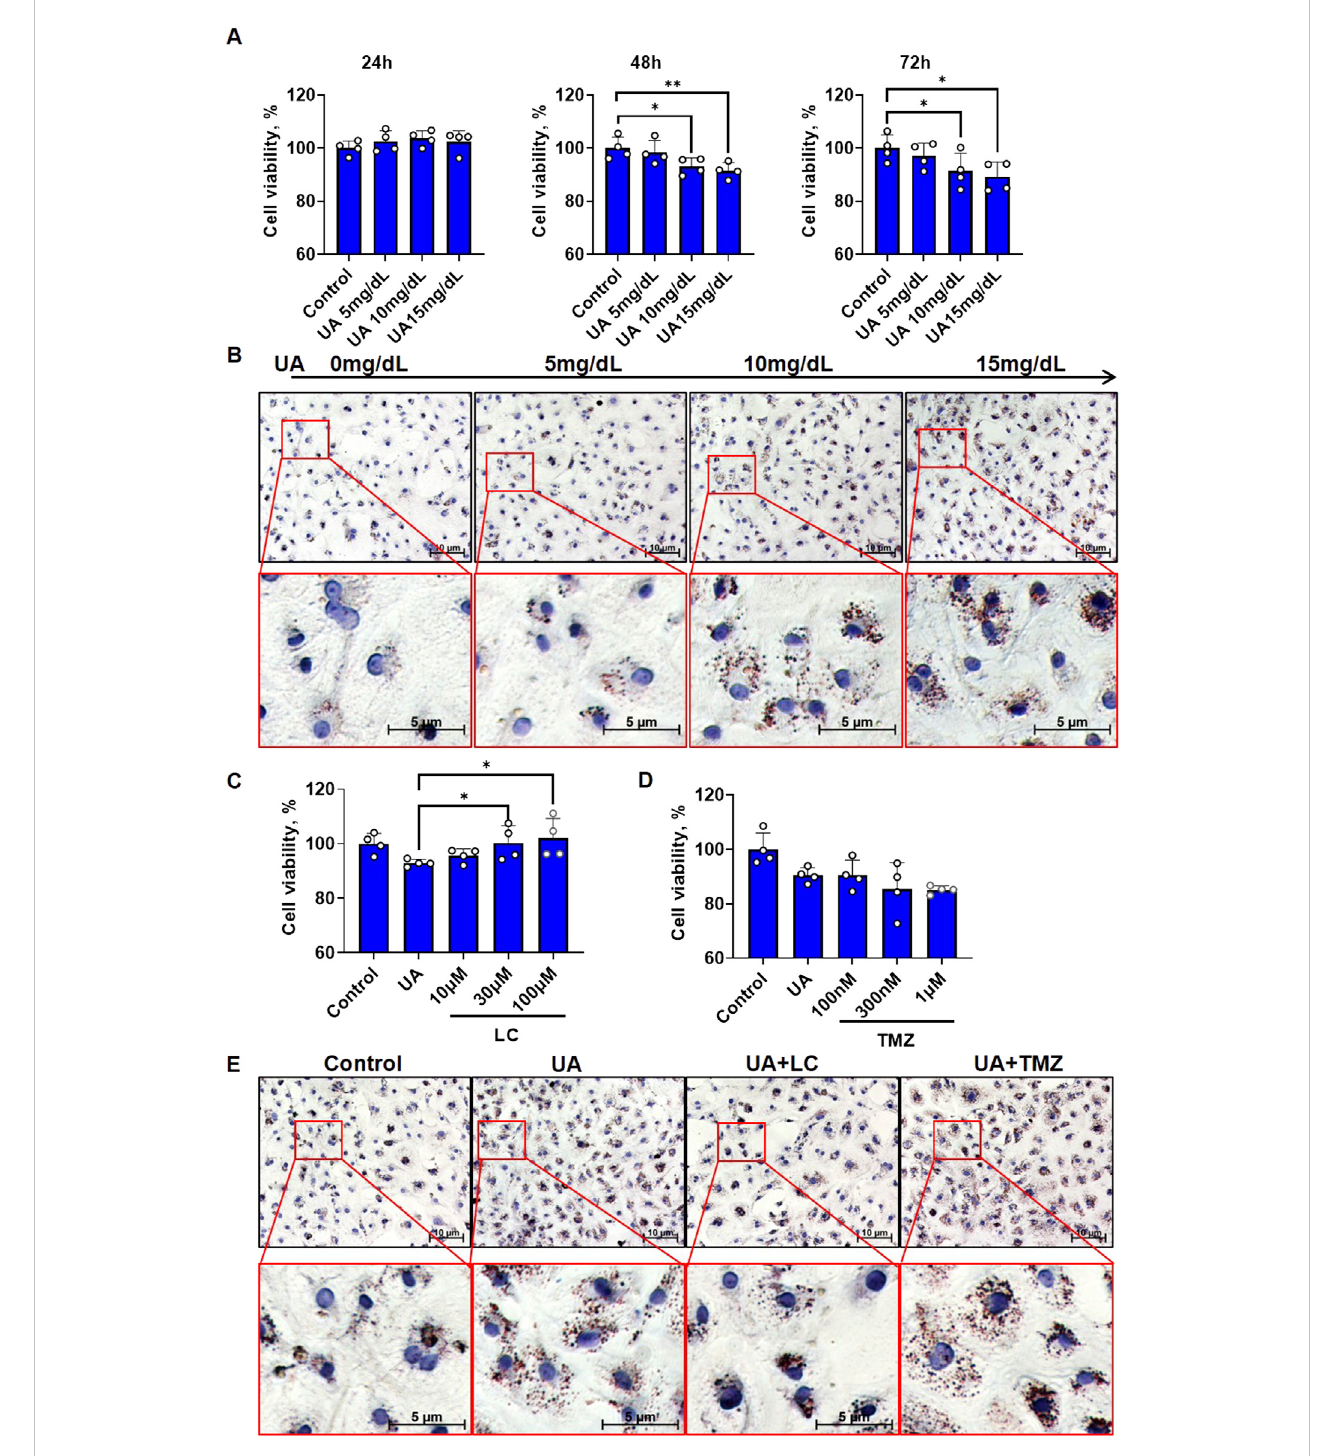
FIGURE 1 FA metabolic agents intervention affected UA induced cardiomyocyte injury. (A) The time-course of cell viability under different concentrations of UA exposure. The results were normalized to the mean value of control ( n = 4); (B) Oil red O staining showing cardiomyocytic lipid deposition under different concentrations of UA exposure for 24 h. Dark red indicates deposited lipid, Blue indicated nuclei; (C) The in fl uence of LC intervention on cell viability of cardiomyocytes under UA stimulation. UA concentration is 15 mg/dL. The cells were examined after 48 h treatment. The results were normalized to the mean value of control ( n = 4); (D) The in fl uence of TMZ intervention on cell viability of cardiomyocytes under UA stimulation. UA concentration is 15 mg/dL. The cells were examined after 48 h treatment. The results were normalized to the mean value of control ( n = 4); (E) Oil red O staining showing UA induced cardiomyocytic lipid deposition under LC or TMZ intervention. UA concentration is 15 mg/dL, LC concentration is 100 μ M, TMZ concentration is 1 μ M. The cells were fi xed for examination after 24 h treatment. Dark red indicates deposited lipid, Blue indicates